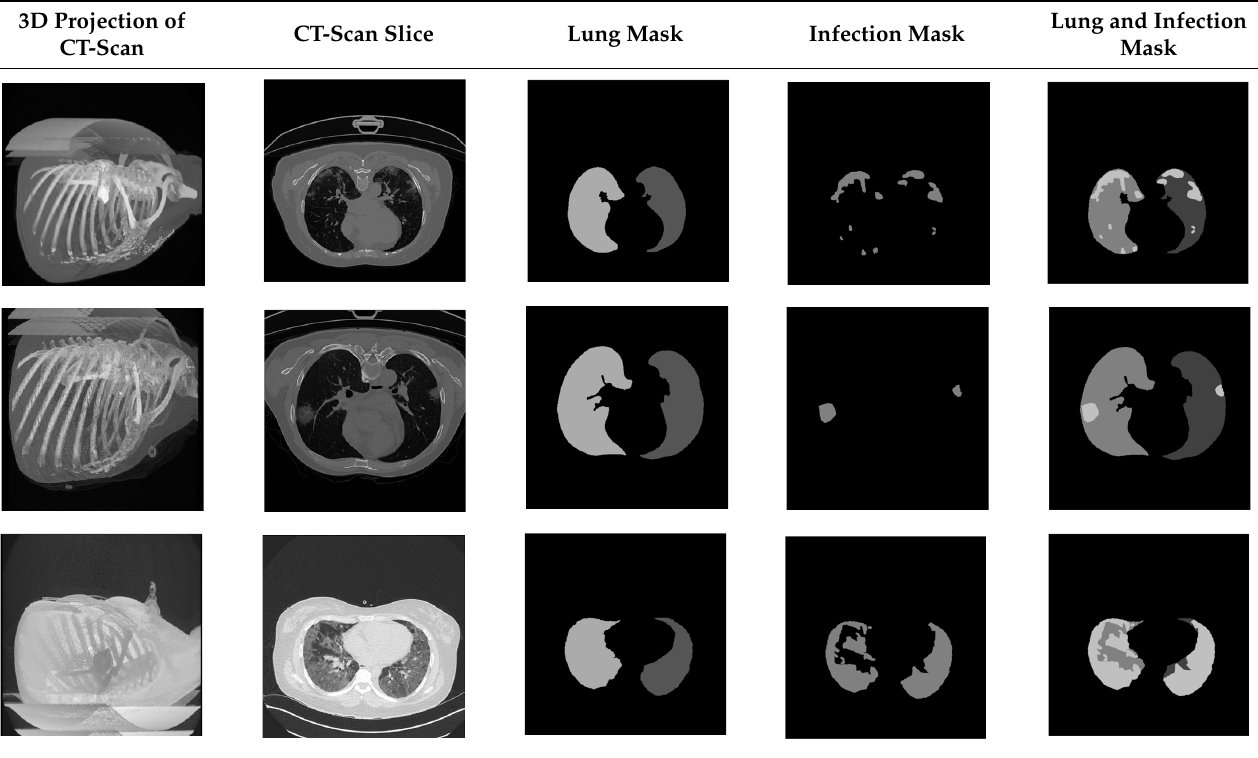
Table 3. Source, infection severity, and size information for each patient’s CT-scan.